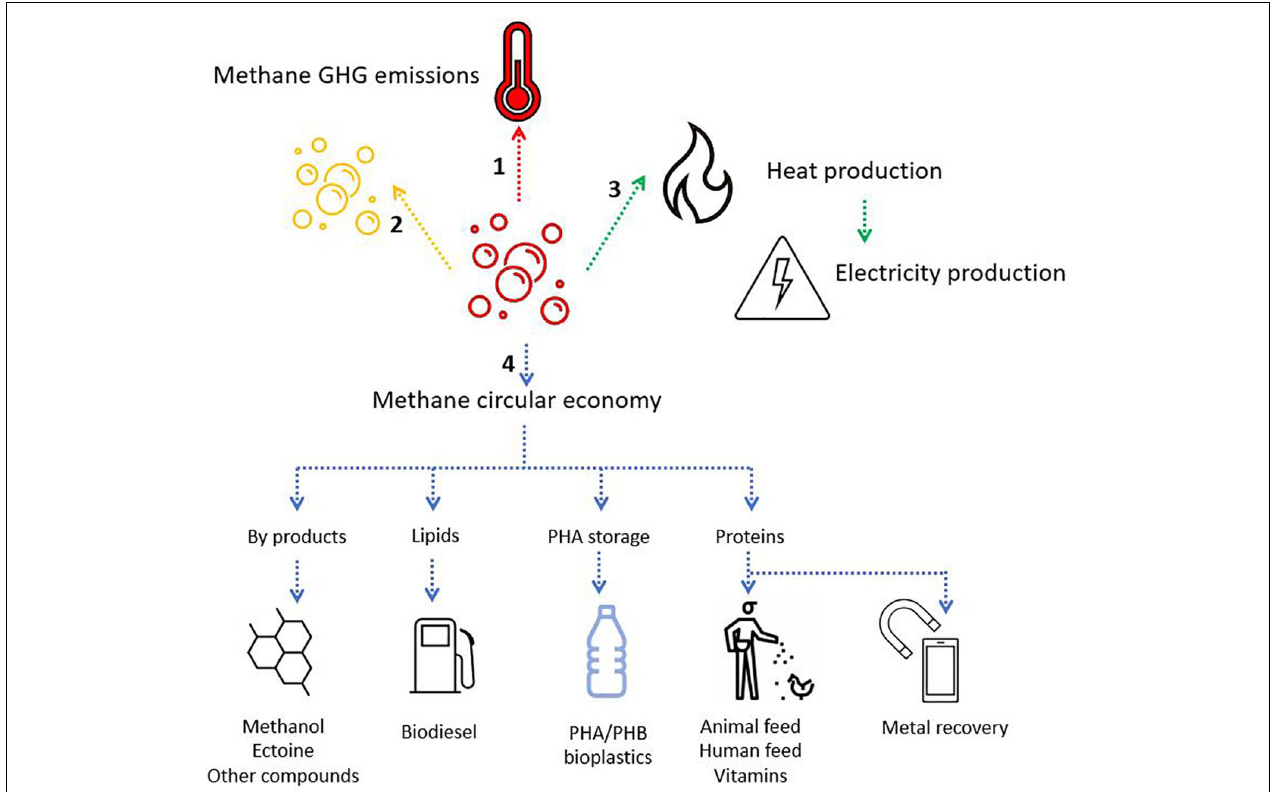
FIGURE 8 | Schematic representation of the fate of methane. (1) No action leads to methane-GHG release to the atmosphere (red arrow). (2) Methane can be neutralized into CO 2 , a less harmful GHG (in a short timescale) (yellow arrow). Methane oxidation can occur aerobically or anaerobically depending on the availability of electron acceptors and the microorganisms present. (3) Methane can be collected and used as a biogas for heat and electricity production (green arrow). (4) Methane can enter bio-based and circular economy models through the application of aerobic methanotrophs for the production of various chemicals, biodiesel, bioplastics, protein, and even the potential recovery of precious metals (blue